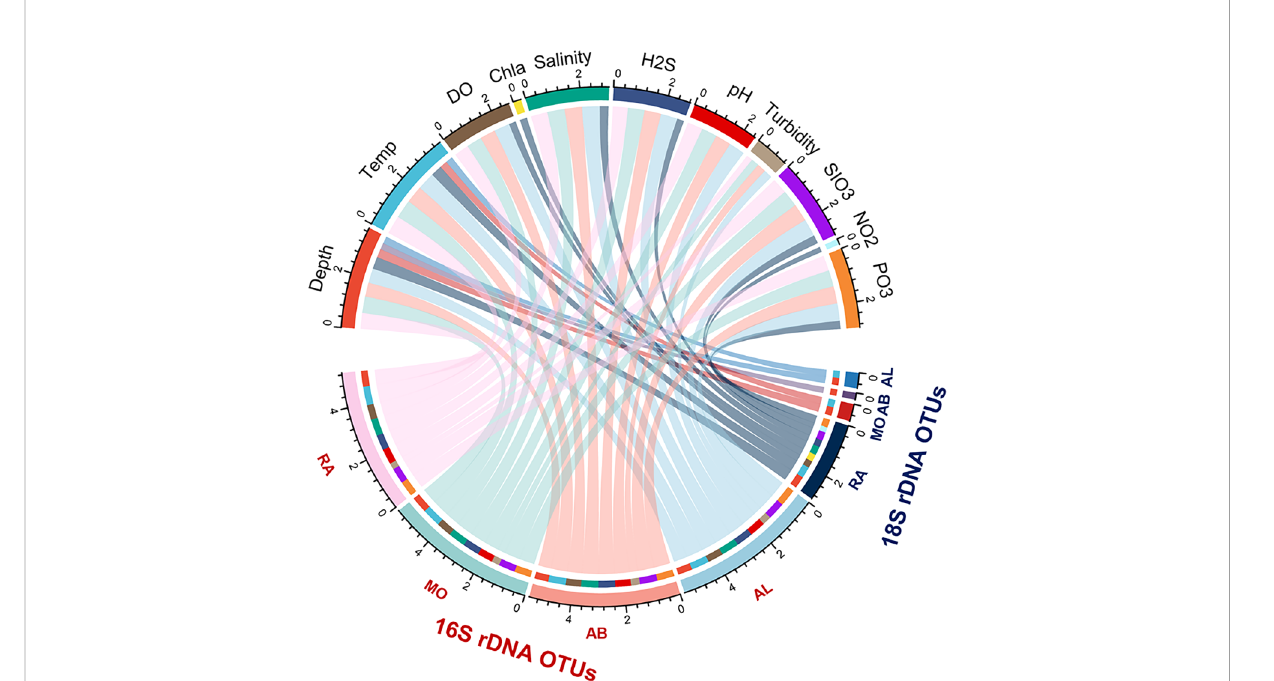
FIGURE 4 The circos plot depicts the effects of environmental variables on the beta diversity of microeukaryotes and prokaryotes plankton communities revealed by Mantel tests. Each environmental variable and subcommunity are depicted by the arcs. The correlation between the relative abundance of community and environmental variable are depicted by the arcs with speci fi c color. The area of ribbons indicate the contribution of each variables with signi fi cant positive correlation. Detailed results of Mantel test are shown in Supplementary Table 4. RA, Rare subcommunity; MO, Moderate subcommunity; AB, Abundant subcommunity; AL, whole community.